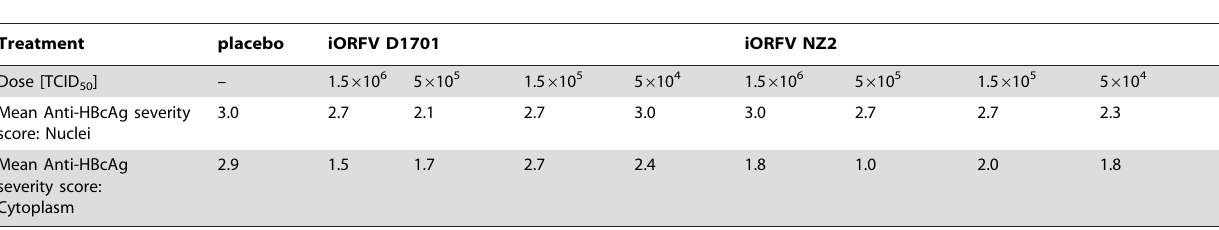
Table 1. Treatment with inactivated ORFV reduces HBV core antigen (HBcAg) in HBV-transgenic mice (n= 7/group).